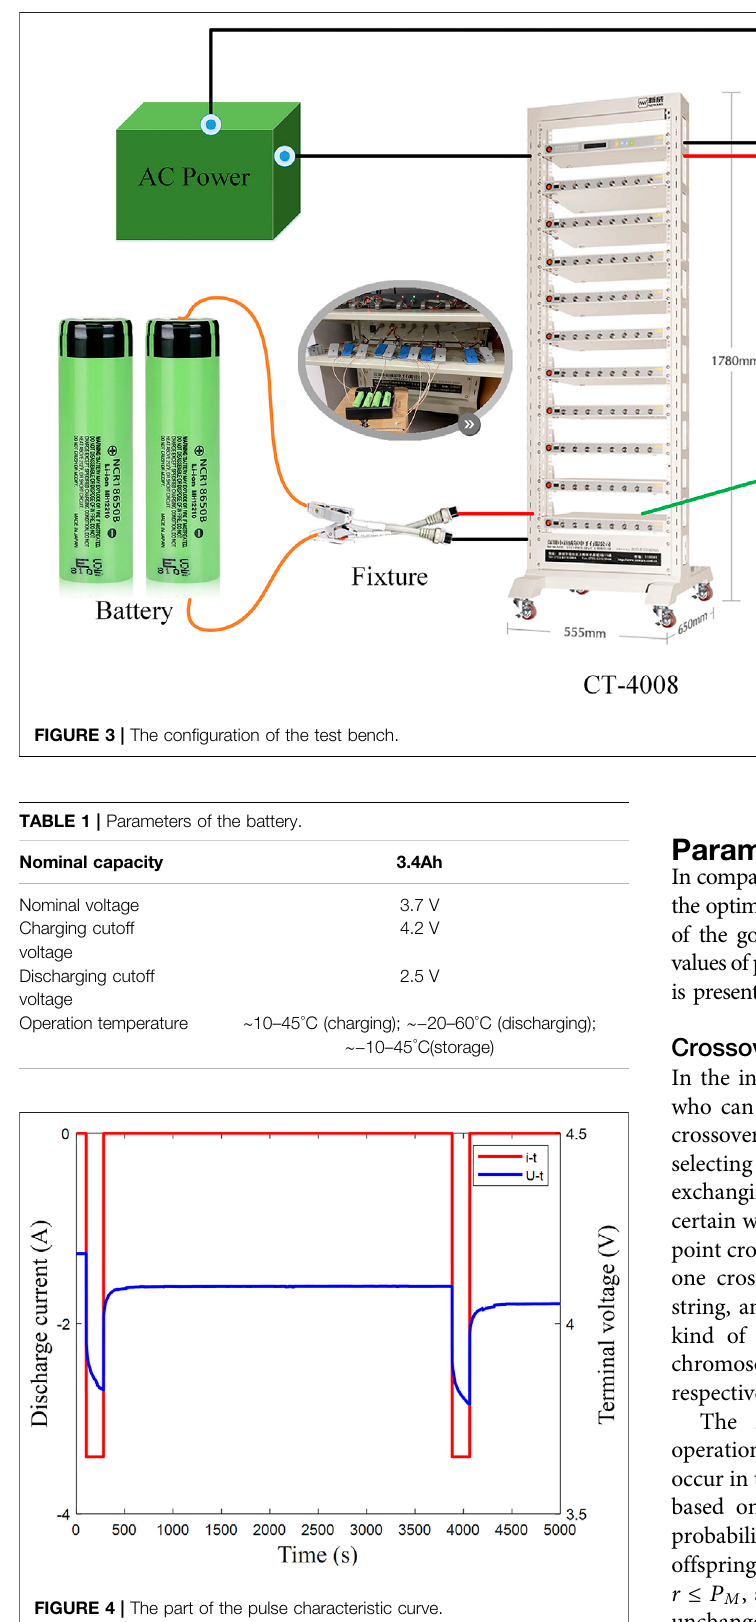
FIGURE 4 | The part of the pulse characteristic